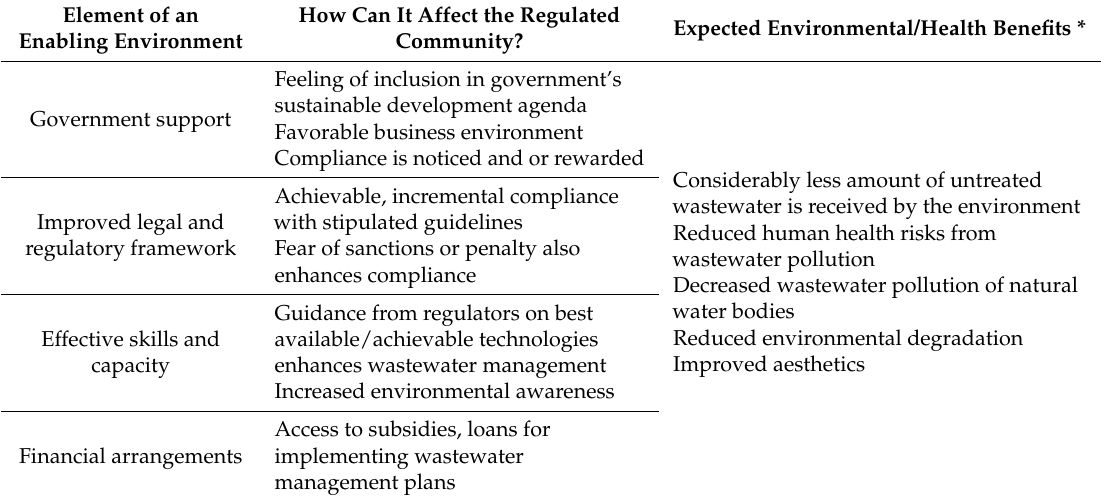
Table 2. Different elements of an enabling environment and its impact on the regulated